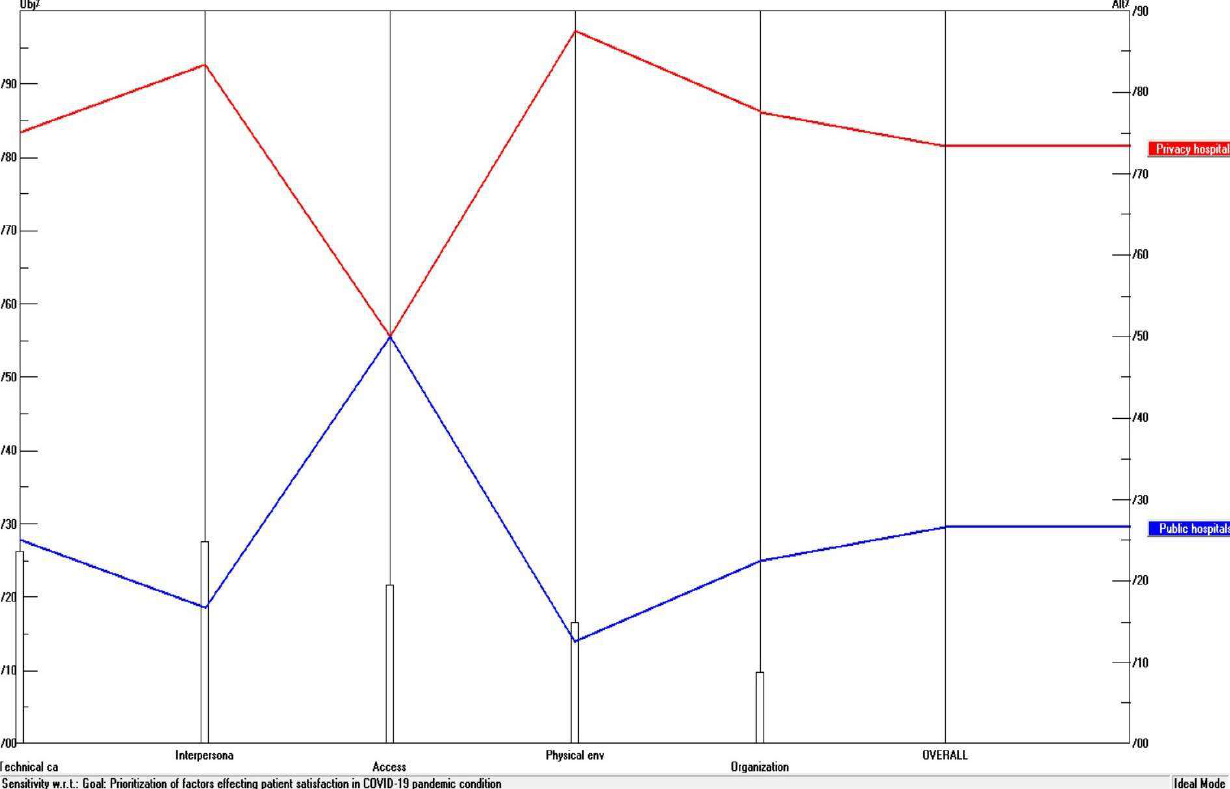
Figure 4. Performance sensitivity analysis.